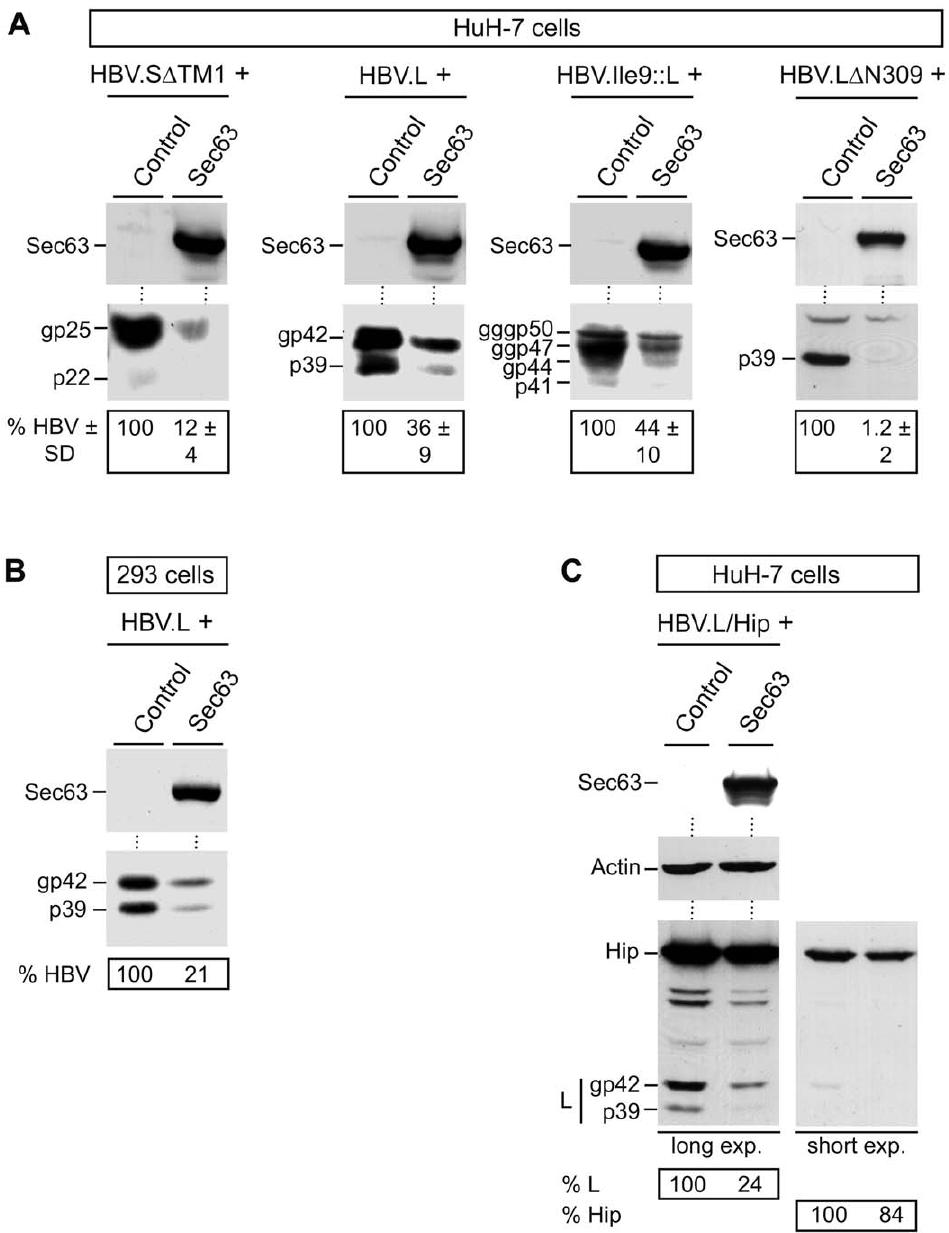
Figure 3. Overexpressing of Sec63 reduces steady-state HBV envelope protein levels irrespective of the secretion status, N- glycosylation, and cell type. A. HuH-7 cells were transfected with HA-tagged HBV.S D TM1, HBV.L, HBV.Ile9::L, or the N-glycosylation-defective HBV.L D N309 mutant in combination with control DNA or Myc-tagged Sec63 at a 1:3 ratio, respectively. Cell lysates were probed by anti-Myc (top) and anti-HA (bottom) WB. Non-glycosylated (p) and glycosylated (gp, ggp, gggp) forms of the HBV constructs are indicated on the left of each panel. Cell- associated envelope proteins (HBV) were quantitated and demonstrated in percent amount 6 SD relative to control cells ( n =3). B. HEK293T cells were cotransfected with HA-tagged HBV.L and Myc-tagged Sec63 or control DNA and analyzed by specific WB as outlined in A. C. Cells were transfected with the bicistronic plasmid HBV.L/Hip encoding expression units for HA-tagged HBV.L and HA-tagged Hip. Cell extracts were probed by anti-Myc (top), anti- b -actin (middle), and anti-HA (bottom) WB. Long and short exposures of the HA-specific blot plus quantification data are